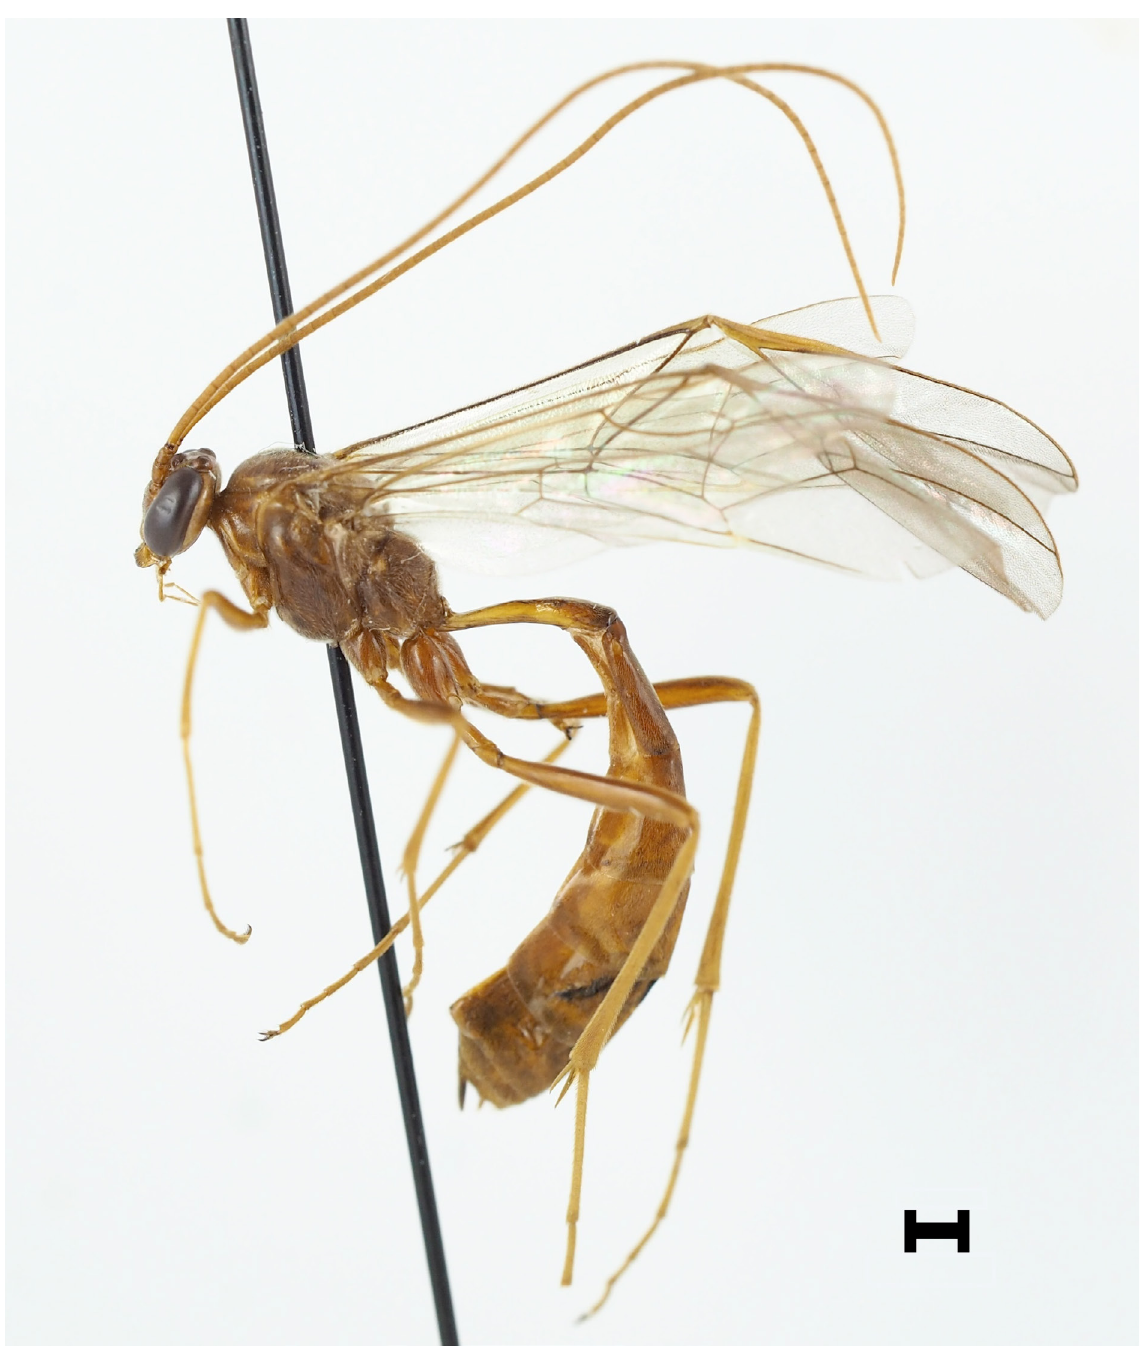
Fig. 44. Ophion tenuicornis Johansson sp. nov., paratype, ♀ (NHRS-HEVA000008743). Scale bar = 1